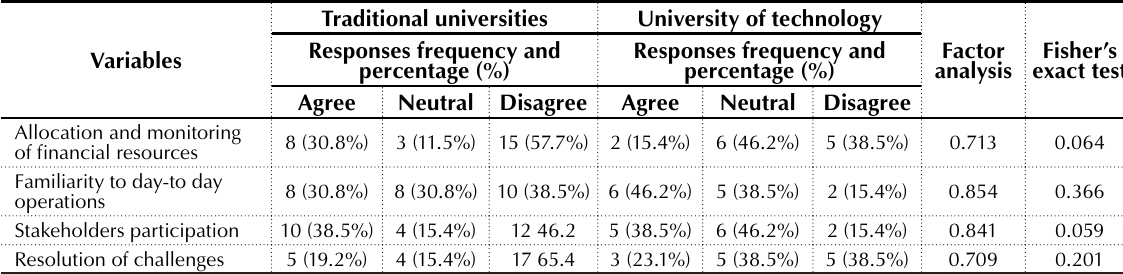
Table 4. Operational Issues at